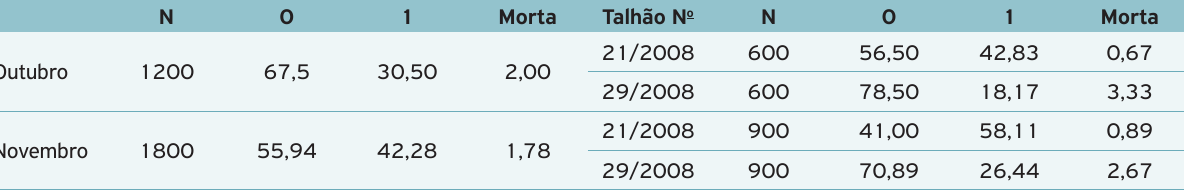
Tabela 3. Porcentagem de árvores atacadas nos meses de outubro e novembro de 2008, e nos talhões 21/2008 e 29/2008 nos respectivos meses. Barão de Cocais (MG).